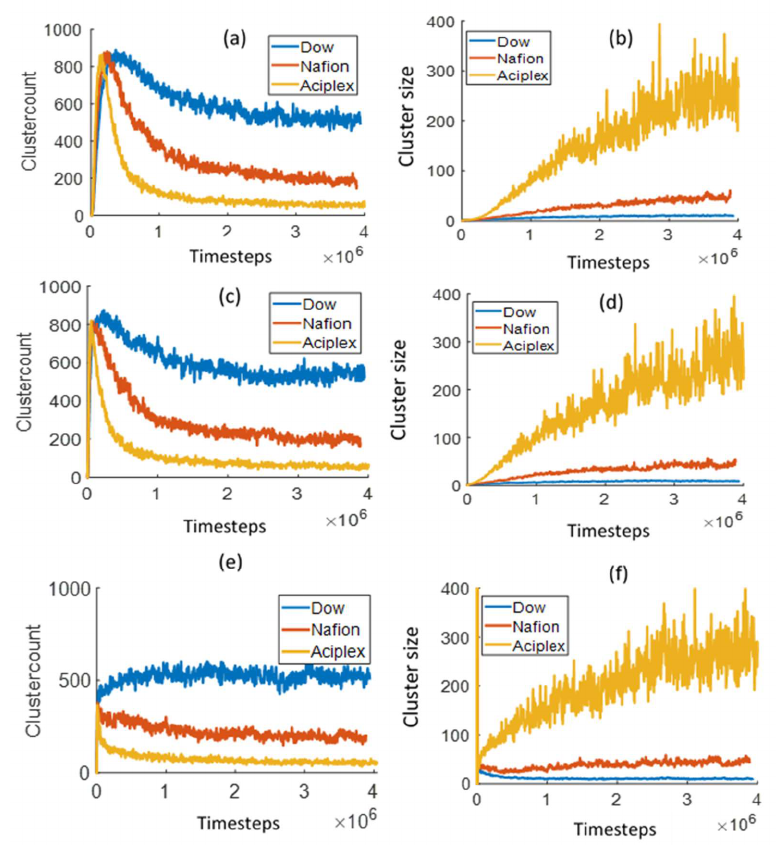
Figure 9. Comparison of the time evolution of water cluster count / number of clusters and average cluster size for different side chain length PEMs in three different layers at distances ranging from ( a , b ) 5–15 DPD units ( c , d ) 15–25 DPD units and ( e , f ) 25–35 DPD units from the bottom Z boundary.